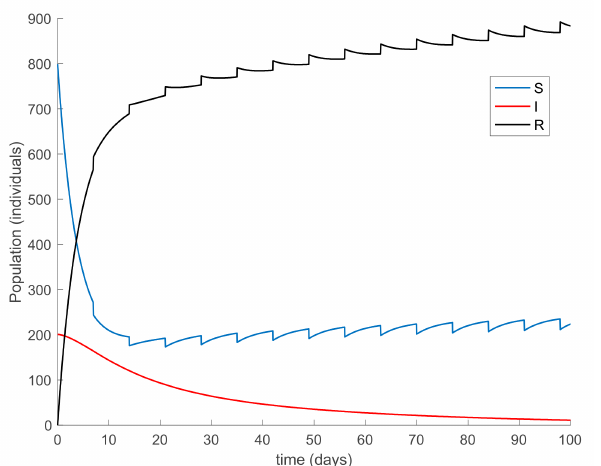
Figure 17. Evolution of all the subpopulations when a variable impulsive vaccination of the suscepti- ble individuals one day per week is added to the previous actions.